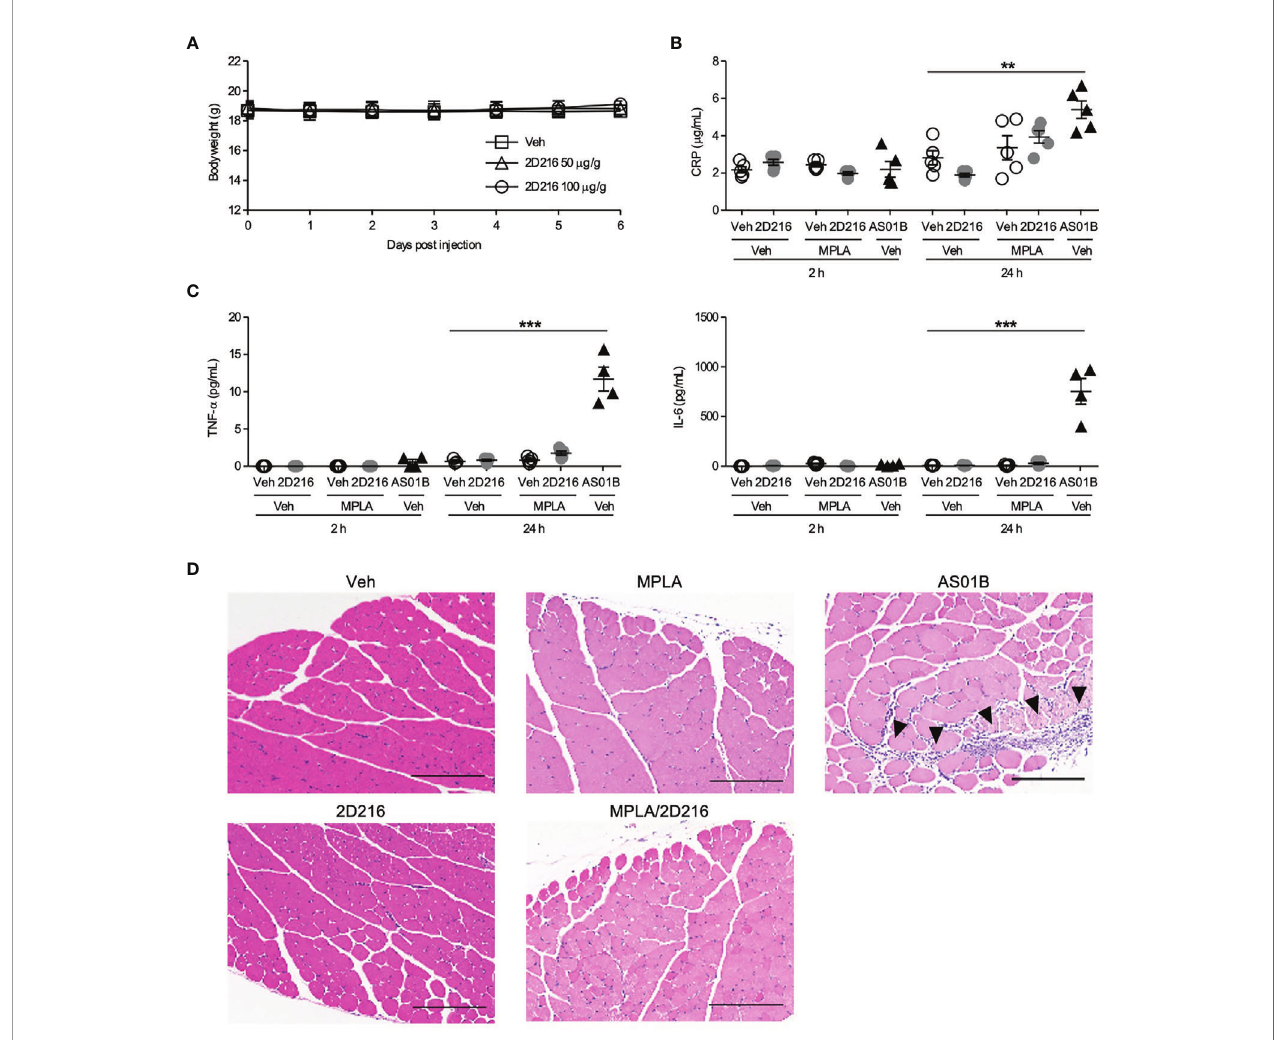
FIGURE 5 | MPLA/ 2D216 shows a minimal local and systemic reactogenicity. (A) Maximal feasible dose test. BALB/c mice (n = 5/group) were intraperitoneally injected with vehicle (Veh; 10%DMSO in saline), or 2D216 (50 and 100 m g/g mouse) on day 0 and body weights were monitored for 7 days. (B – D) BALB/c mice (n = 3-5/group) were i.m. injected with Veh, 2D216 (200 nmol/mouse), MPLA (10 ng/mouse), MPLA/ 2D216 or AS01B (10 m L/mouse). Two and 24 h after the injection, sera were collected, and CRP (B) , TNF- a (C) , and IL-6 (C) levels were determined by ELISA. Data shown are means ± SEM of two independent experiments showing similar results. **p < 0.01, ***p < 0.001 by one-way ANOVA with Dunnett ’ s post hoc test compared to Veh/Veh. (D) Local reactogenicity. After 24 h, the injected muscles were harvested. Examples of H&E stained histological sections are shown (scale bar 200 m m). Arrowheads indicate the areas with in fl ammatory cell in fi ltration. ns, not signi fi